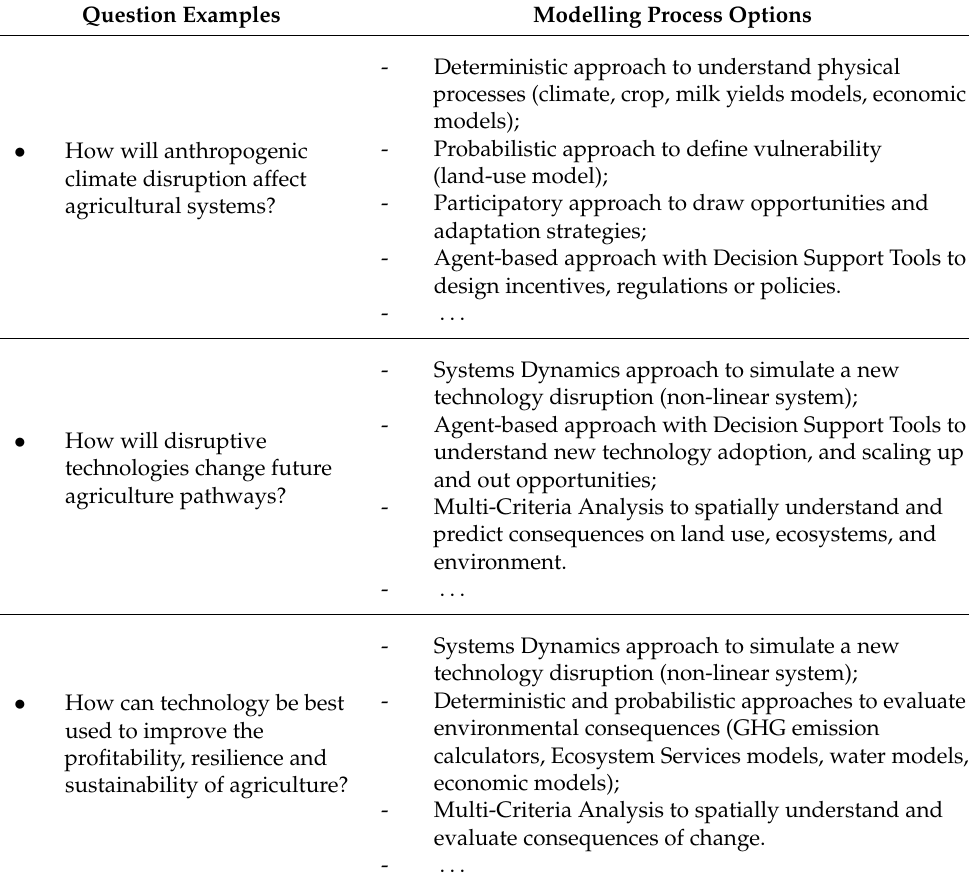
Table 2. Synthesis of example questions and modelling process